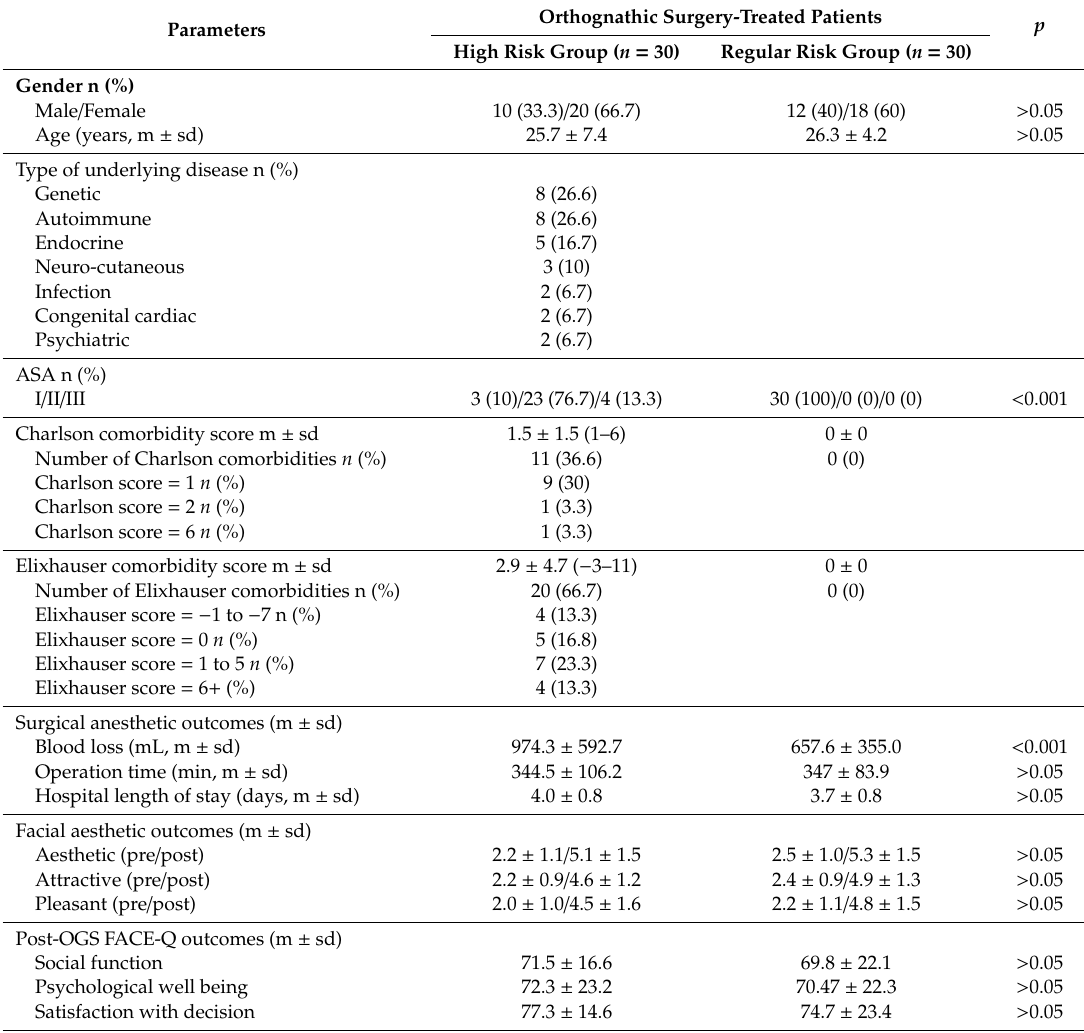
Table 1. Characteristics of and comparative analyses for orthognathic surgery-treated patients with and without underlying high-risk